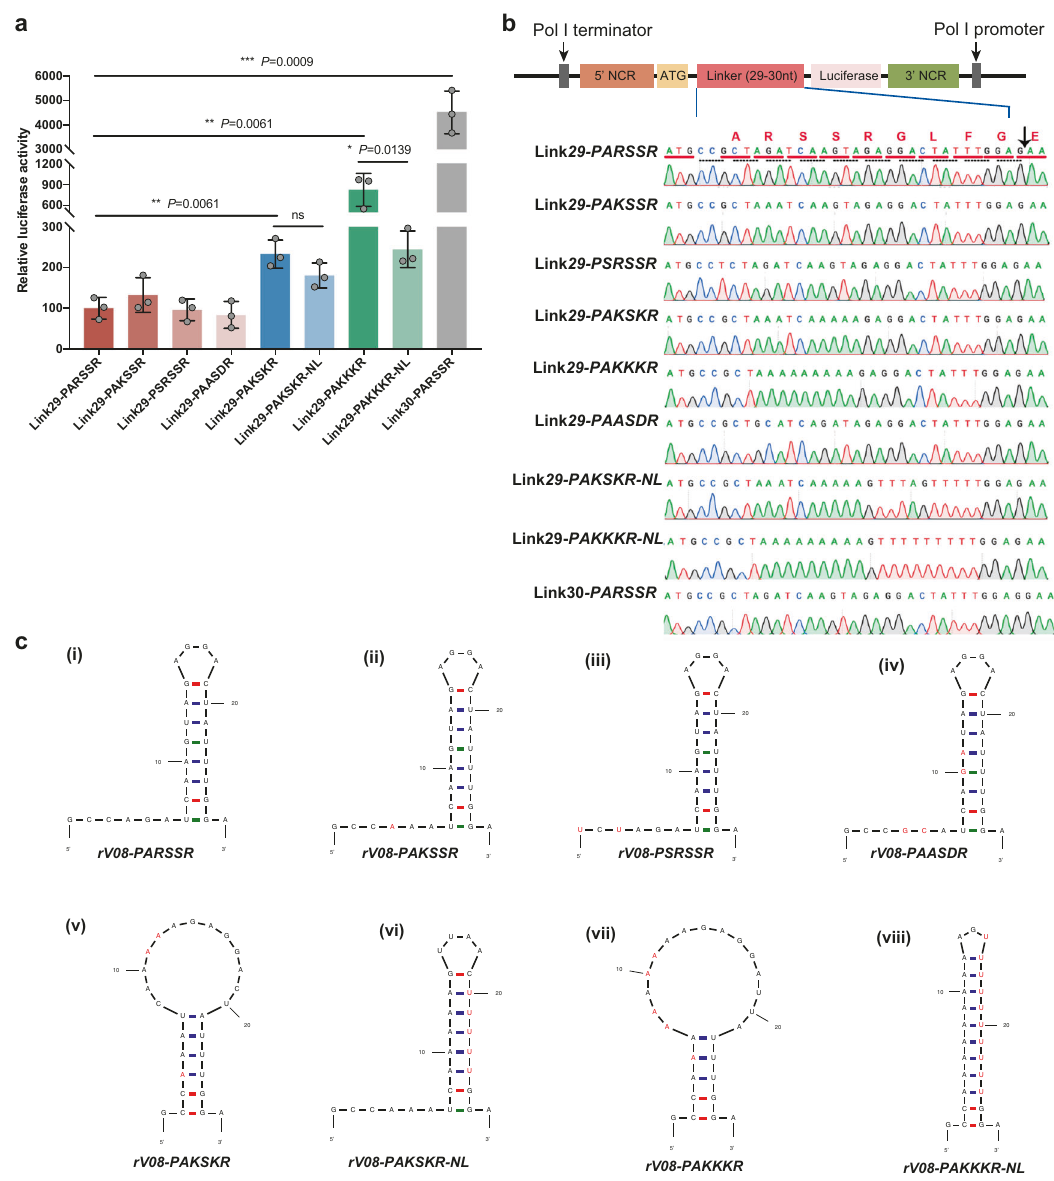
Fig. 4 Quickfold-predicted RNA structures of the HA cleavage sites and luciferase activity in DF-1 cells. DF-1 cells were transfected with plasmid. The predicted RNA secondary structures of each HA cleavage site motif and amino acids corresponding to each codon are shown. Nucleotides different from the PARSSR/G-motif are shown in red. a Luciferase activities were expressed relative to the Link30-PARSSR plasmid and compared among the reporter plasmids containing the different linkers, including Link28-PARSSR, Link29-PARSSR, Link29-PSRSSR, Link29-PAKSSR, Link29-PAKSKR, Link29-PAASDR, Link29-PAKKKR, Link29-PAKSKR-NL, and Link29-PAKKKR-NL. Each point on the curve is the mean±standard deviation from three independent experiments. The independent- samples t test was used for analysis. b The linker 29 and 30 polynucleotides were inserted between a start codon and the fi re fl y luciferase gene lacking its start codon. c Quickfold-prediction RNA structures of the HACS sequences. The predicted RNA secondary structure of rV08-PARSSR (i), rV08-PAKSSR (ii), rV08- PSRSSR (iii), rV08-PAASDR (iv), rV08-PAKSKR (v), rV08-PAKSKR-NL (vi), rV08-PAKKKR (vii), and rV08-PAKKKR-NL (viii) are shown. Nucleotides different from the parental rV08-PARSSR are shown in